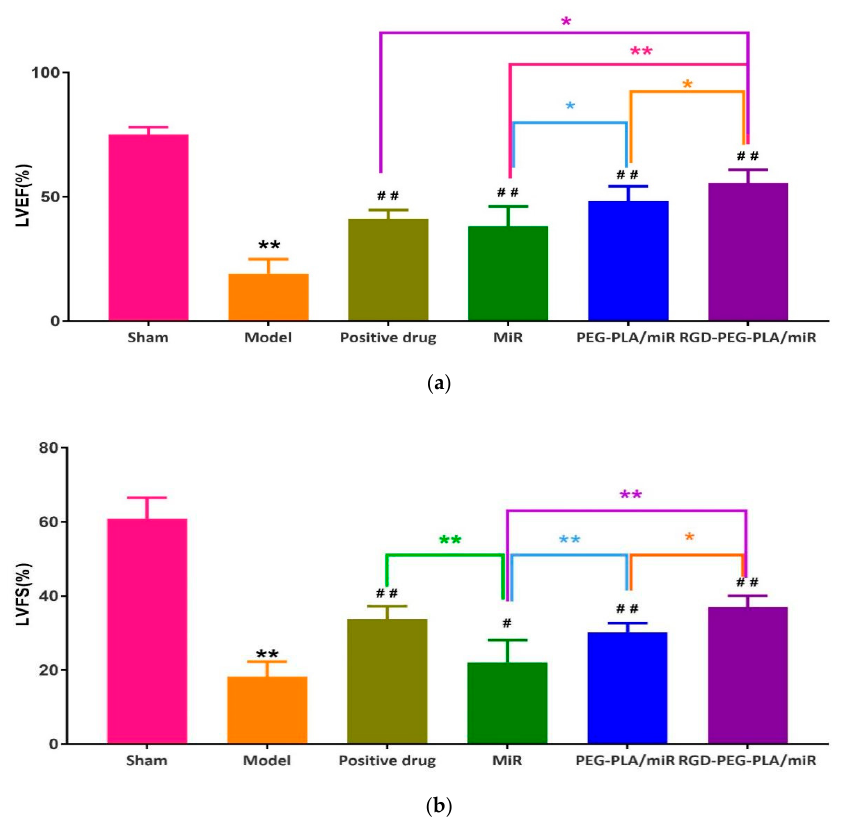
Figure 6. Results of ( a ) left ventricular ejection fraction (LVEF) and ( b ) left ventricular fraction shortening (LVFS) on echocardiography in six groups of rats (mean ± SD, n = 6). Compared with the sham group, the di ff erence was statistically significant (** p < 0.01). Compared with the model group, the di ff erence was statistically significant ( # p < 0.05, ## p < 0.01). The color asterisks indicate significant di ff erences between the two groups, * p < 0.05 and ** p <